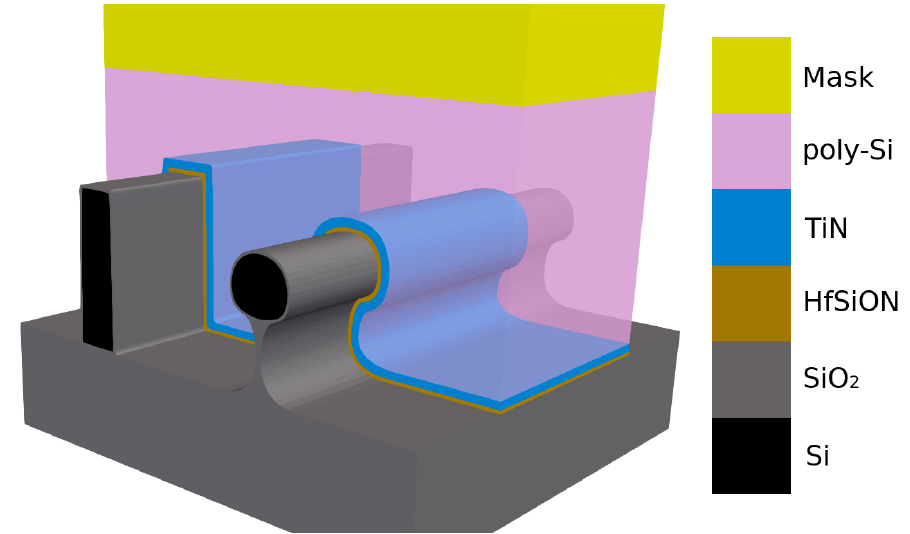
Figure 12. Schematic depiction of multi-layered geometries of modern three-dimensional gate structures after gate etching. A trigate (left) will have three sides of the Si-channel accessible to the gate, while an Ω -gate (right) comes close to an all-around gate